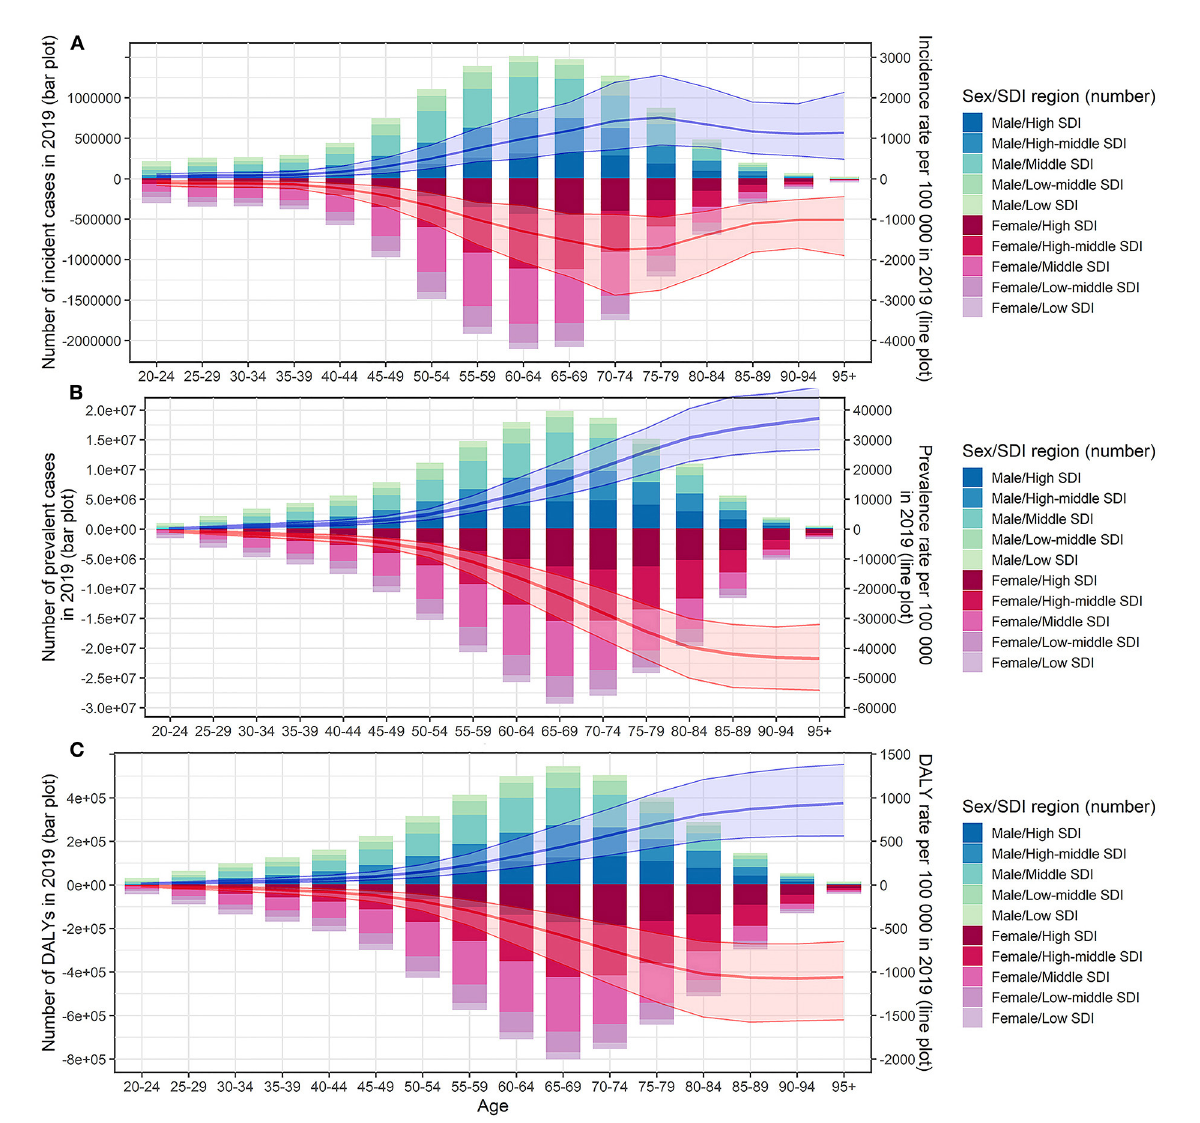
FIGURE1 Incident cases, prevalent cases, DALYs and the corresponding rates of edentulism by sex, age group, and SDI regions in 2019. (A) Incident cases and incidence rate; (B) prevalent cases and prevalence rate; (C) DALYs and DALY rate. DALYs, disability-adjusted life years; SDI, socio-demographic